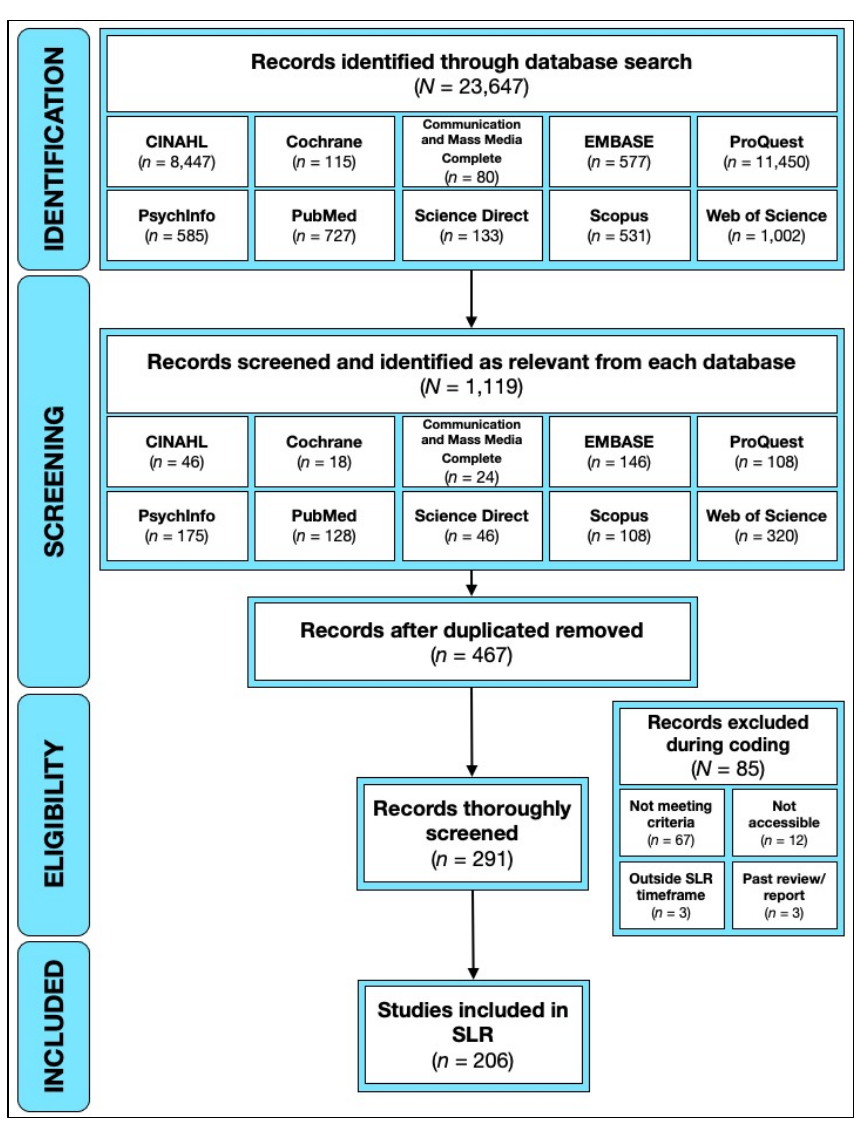
Figure 1. PRISMA Flow Diagram.